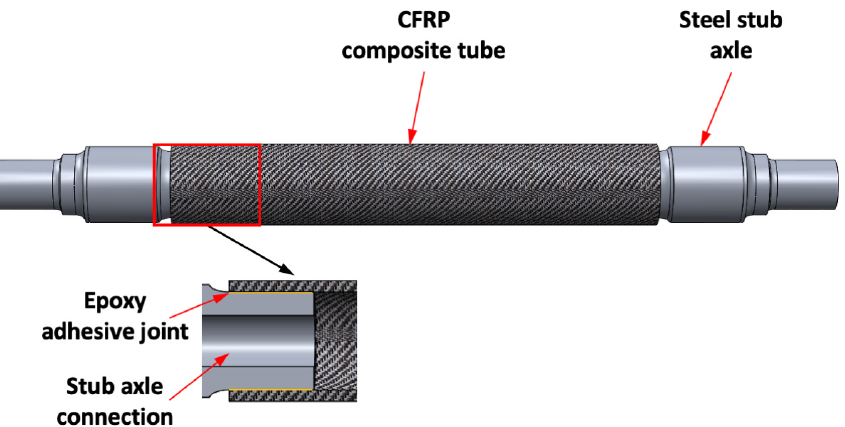
Figure 3. Construction of the unoptimised structural hybrid metallic-composite railway axle de- sign concept.